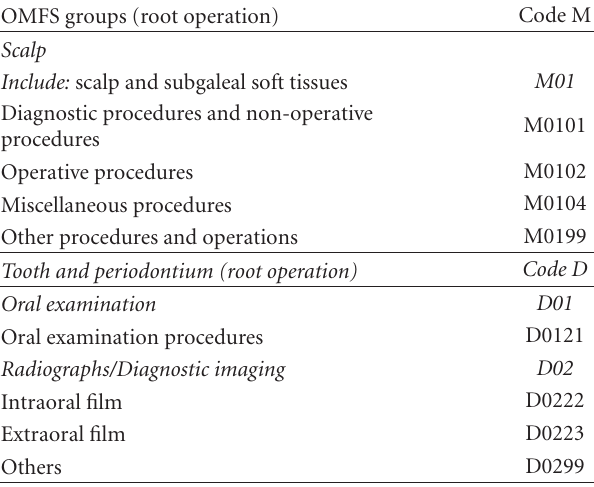
Table 2: Examples of the procedure clusters, split into subgroups of procedure clusters using a root